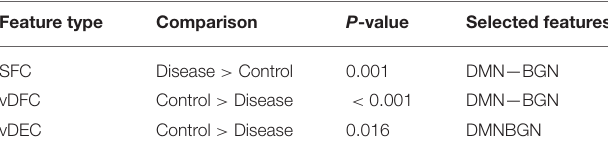
TABLE 18 | Network-to-network interactions selected by enrichment analysis for PTSD dataset. Feature